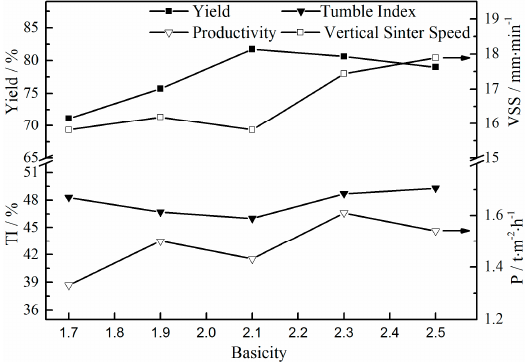
ff ect of basicity on sinter properties. Figure 1. Effect of basicity on sinter properties. Figure 1. E